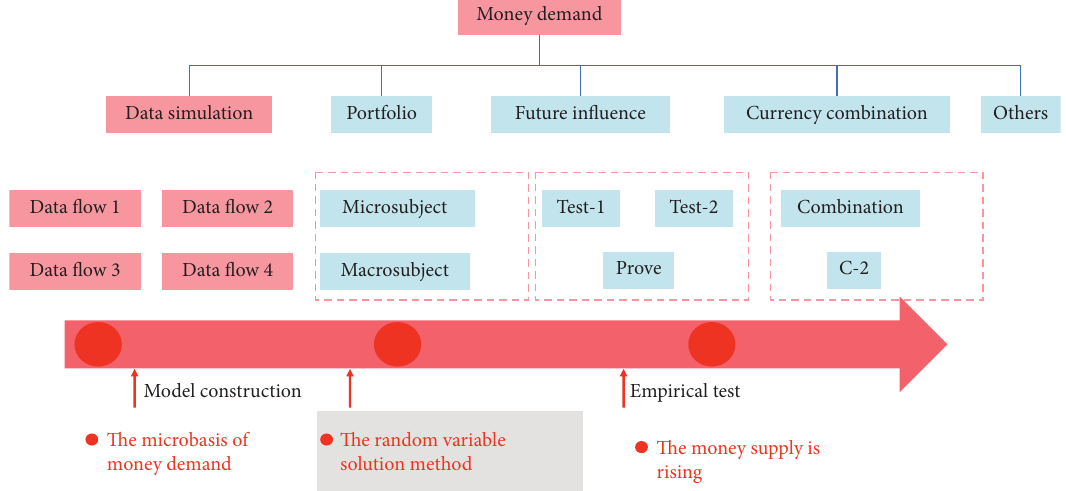
Figure 1: Schematic diagram of the concept of the copula